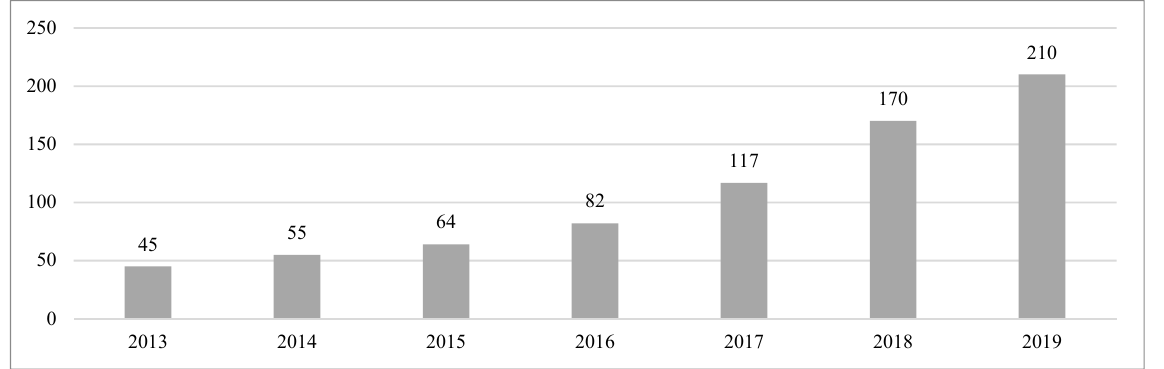
Figure 3. Number of FinTech companies in Lithuania.